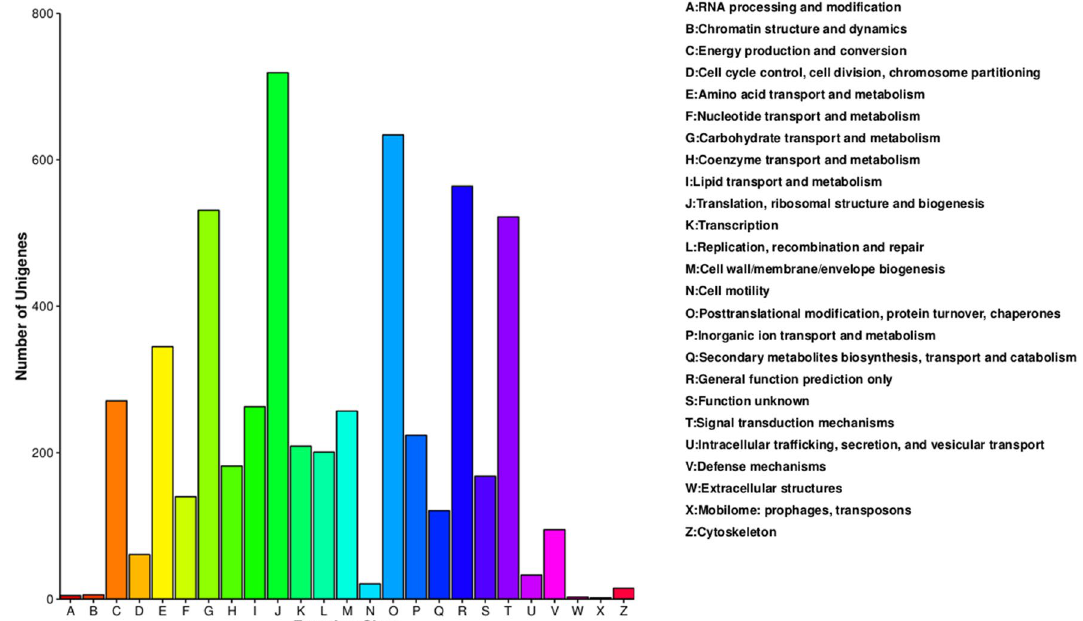
Figure 3. Classification of top 25 unigenes under Clusters of Orthologous Groups (COG). X-axis indicates COG function class and y-axis indicates the number of unigenes.